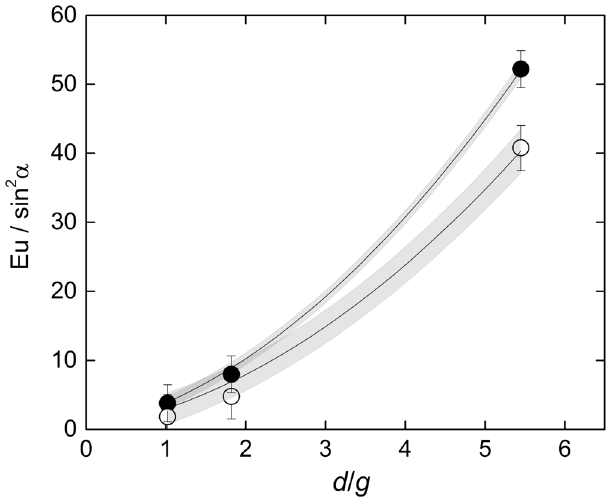
Figure 7. Dependence of the drag coefficient with d / g for the pressure drop between the front and the back of the rod ( Eu 0 − 180 ) and the total pressure drop between the channel inlet and outlet. The grey zones are the 67% confidence bands of the correlations. Created with Gnuplot 5.4, www. gnupl ot.